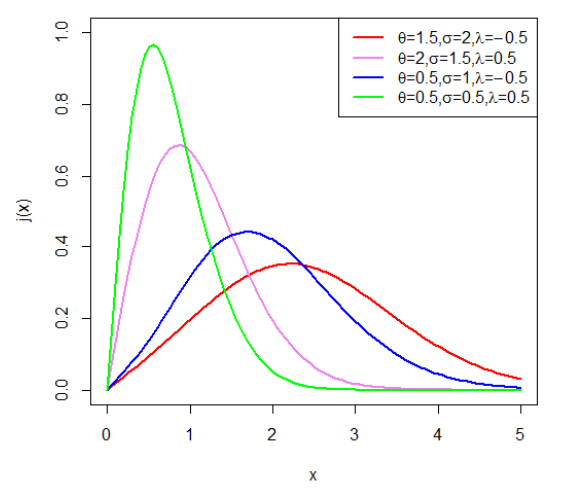
Figure 4 – Pdf of ET R distribution for various choices of θ , σ and λ .